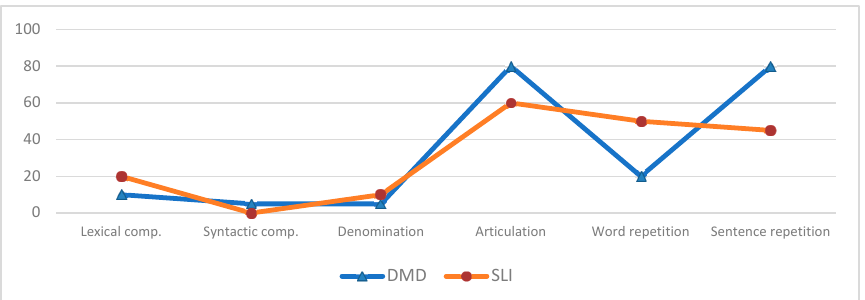
Figure 1. Percentage distribution of abnormal results on the language tests in the DMD and SLI groups. Table 1. Comparison of the specific language impairment (SLI) and Duchenne muscular dystrophy (DMD) groups regarding administered tests.